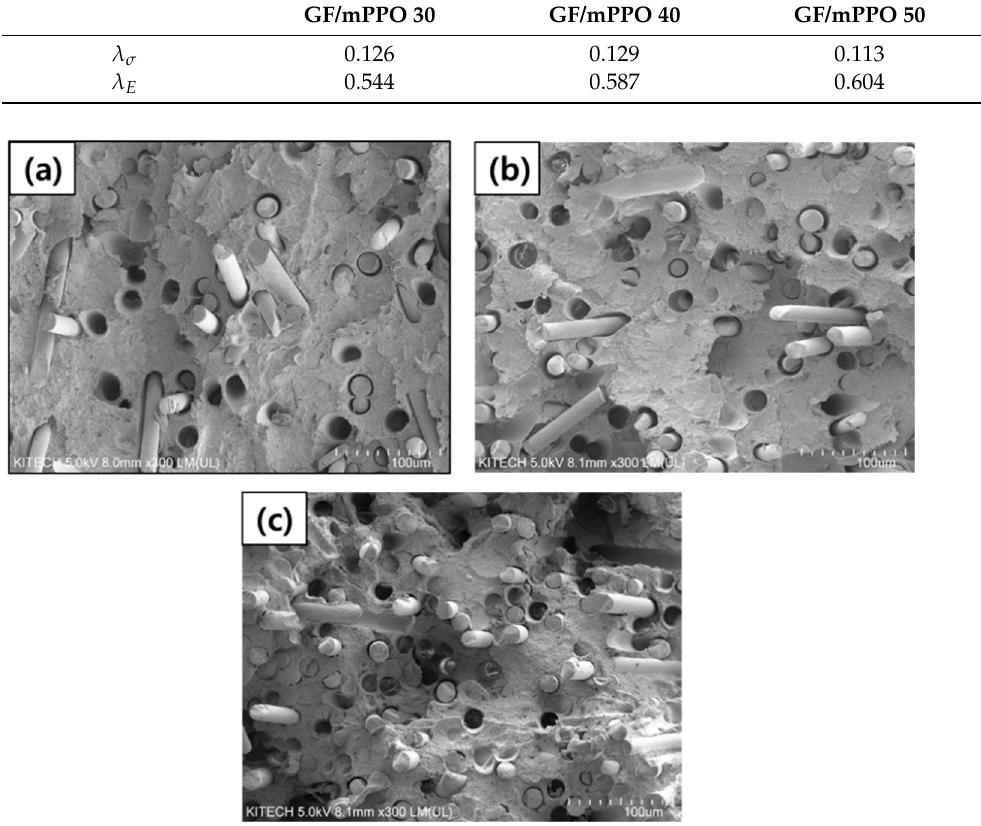
Figure 6. Fracture morphologies of the GF/mPPO composites; ( a ) GF/mPPO 30, ( b ) GF/mPPO 40, and ( c ) GF/mPPO 50.